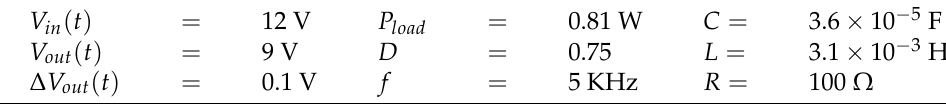
Table 1. Buck converter